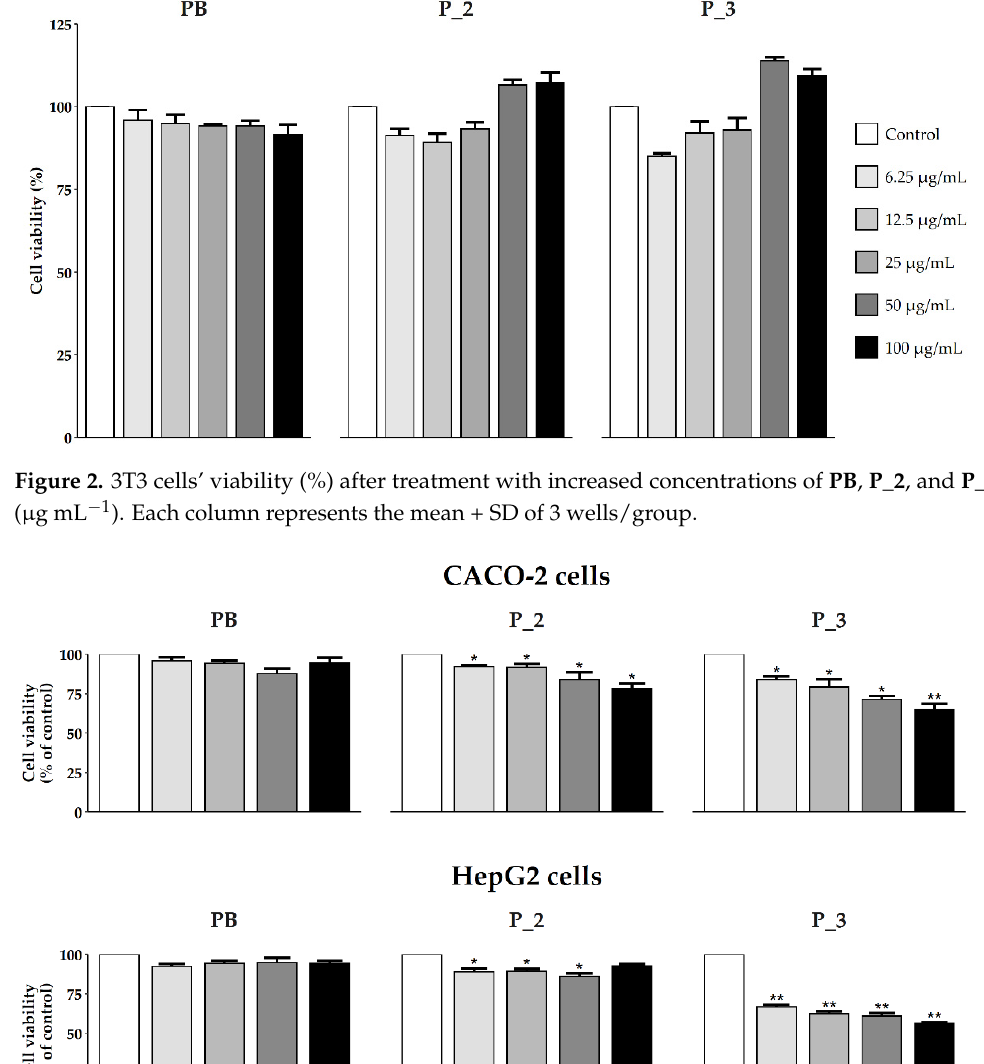
Figure 2. 3T3 cells’ viability (%) after treatment with increased concentrations of PB , P_2 , and P_3 (µg mL − 1 ). Each column represents the mean + SD of 3 wells/group.